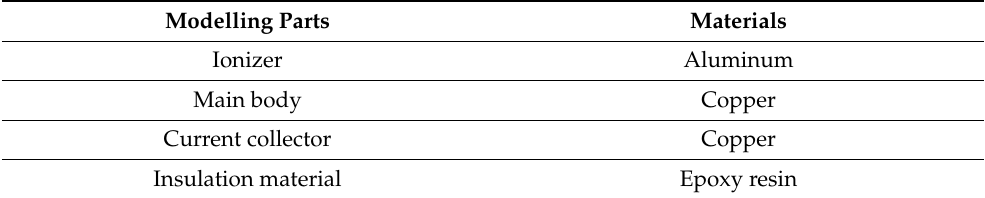
Figure 1. Computer-aided design representation of the numerical model geometry. Table 2. Each material for simulation model.